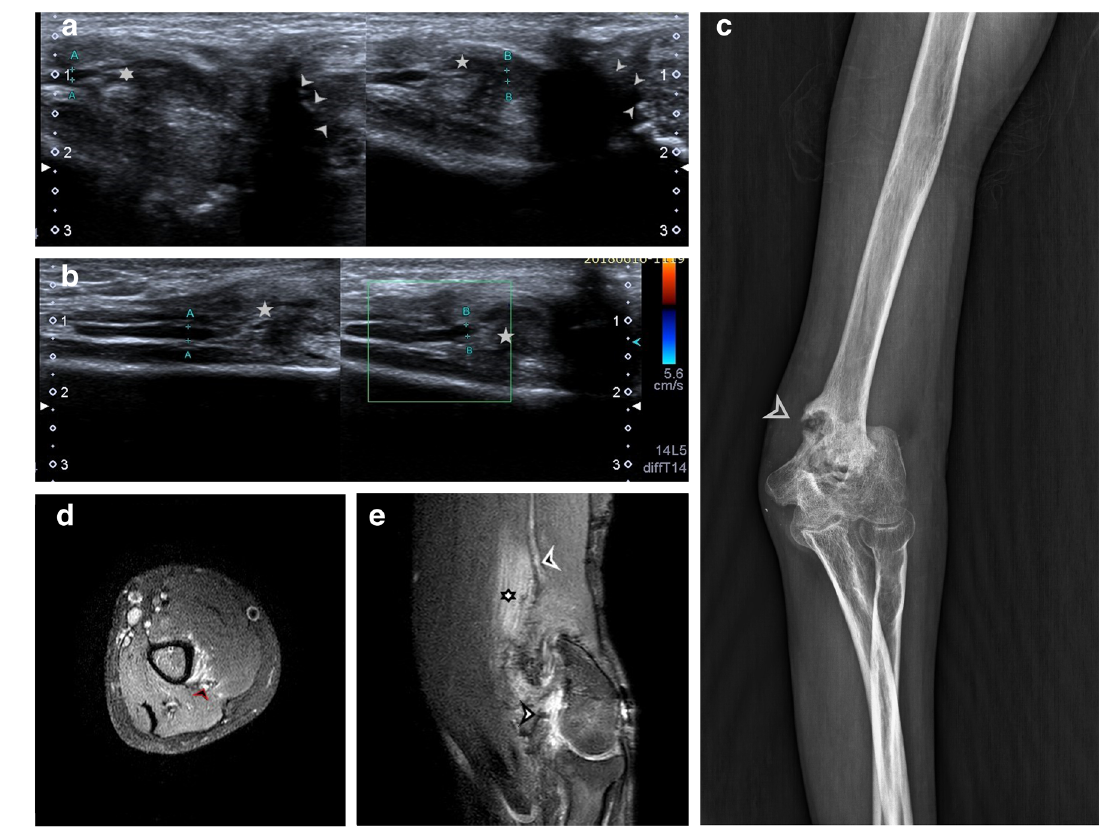
(black arrowhead) with surrounding hyperintense muscle oedema. e Sagittal PD sequence showing heterogeneously hyperintense area of chronic inflammation in region of malunited supracondylar fracture